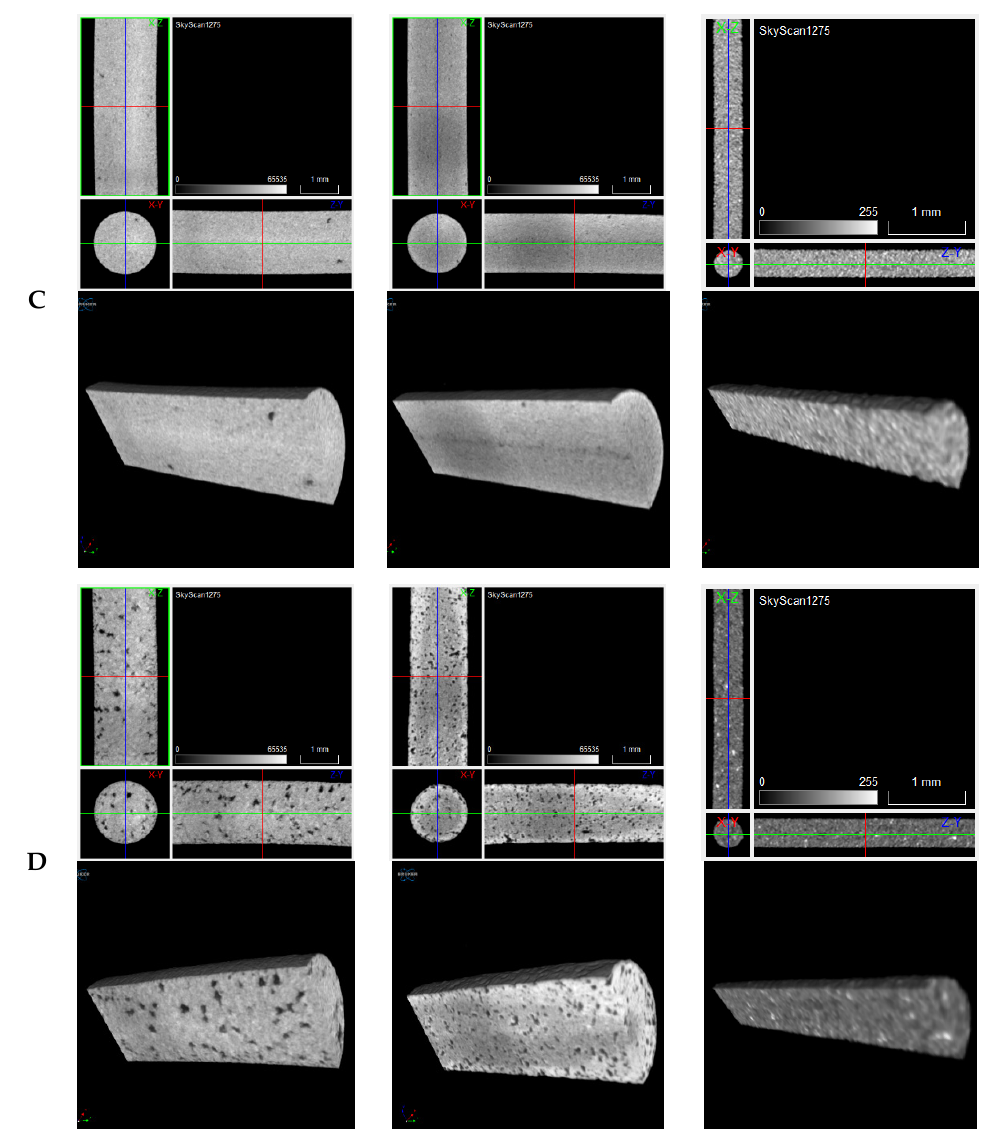
Figure 13. Tomographies of ( A – D ) filaments (green and sintered at 1165 °C during 5 h) and strands ( A – D ) (green).